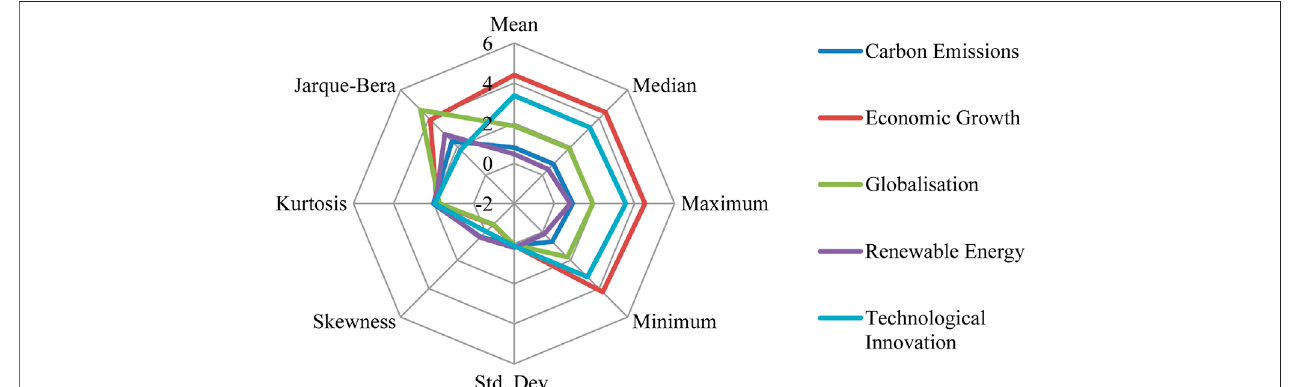
FIGURE 3 | RADAR chart.